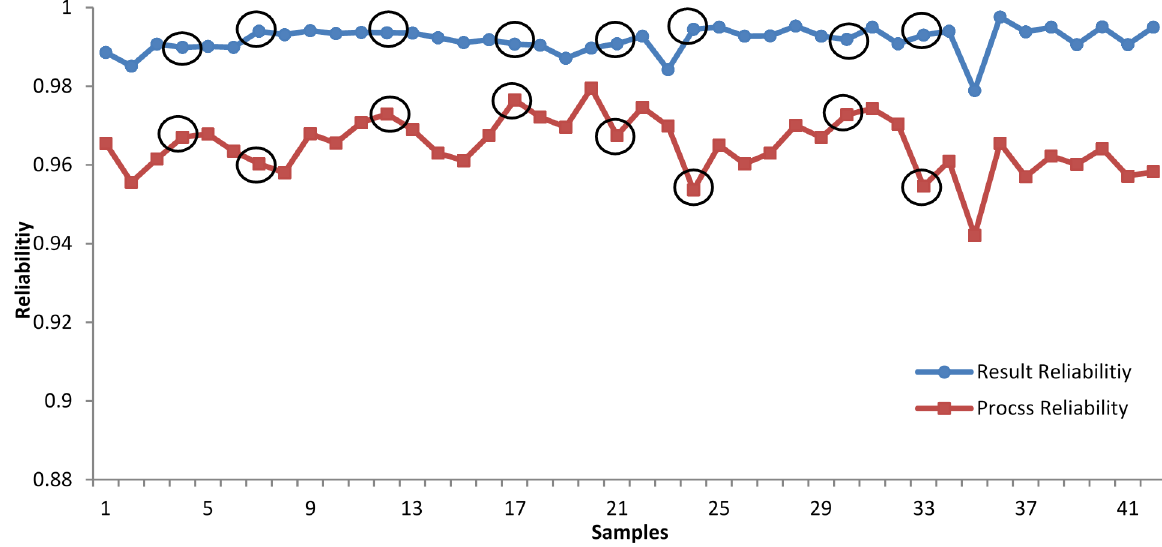
Figure 7. Comparison between first-level result reliabilities and process